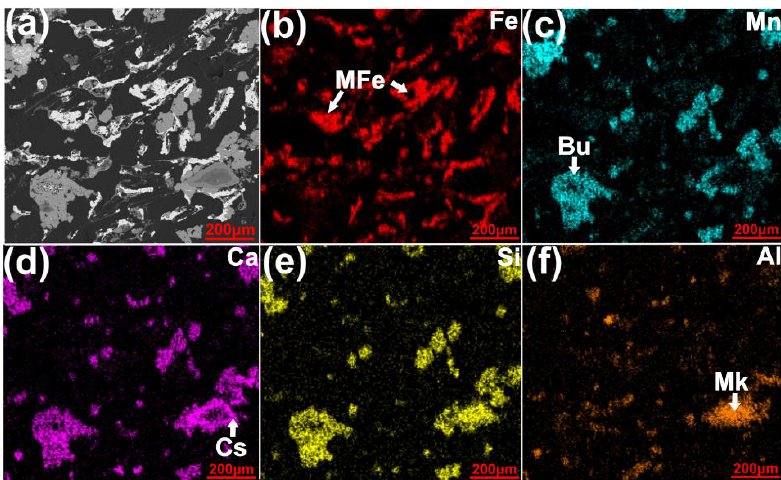
Figure 9. BSE image ( a ) and elemental mapping ( b – f ) of the reduced product (after water-leaching) with 20 wt% CaCl 2 addition (MFe: metallic Fe; Bu: bustamite, CaMnSi 2 O 6 ; Cs: a Cl-bearing calcium aluminosilicate; Mk: metakaolin, Al 2 Si 2 O 7 ).